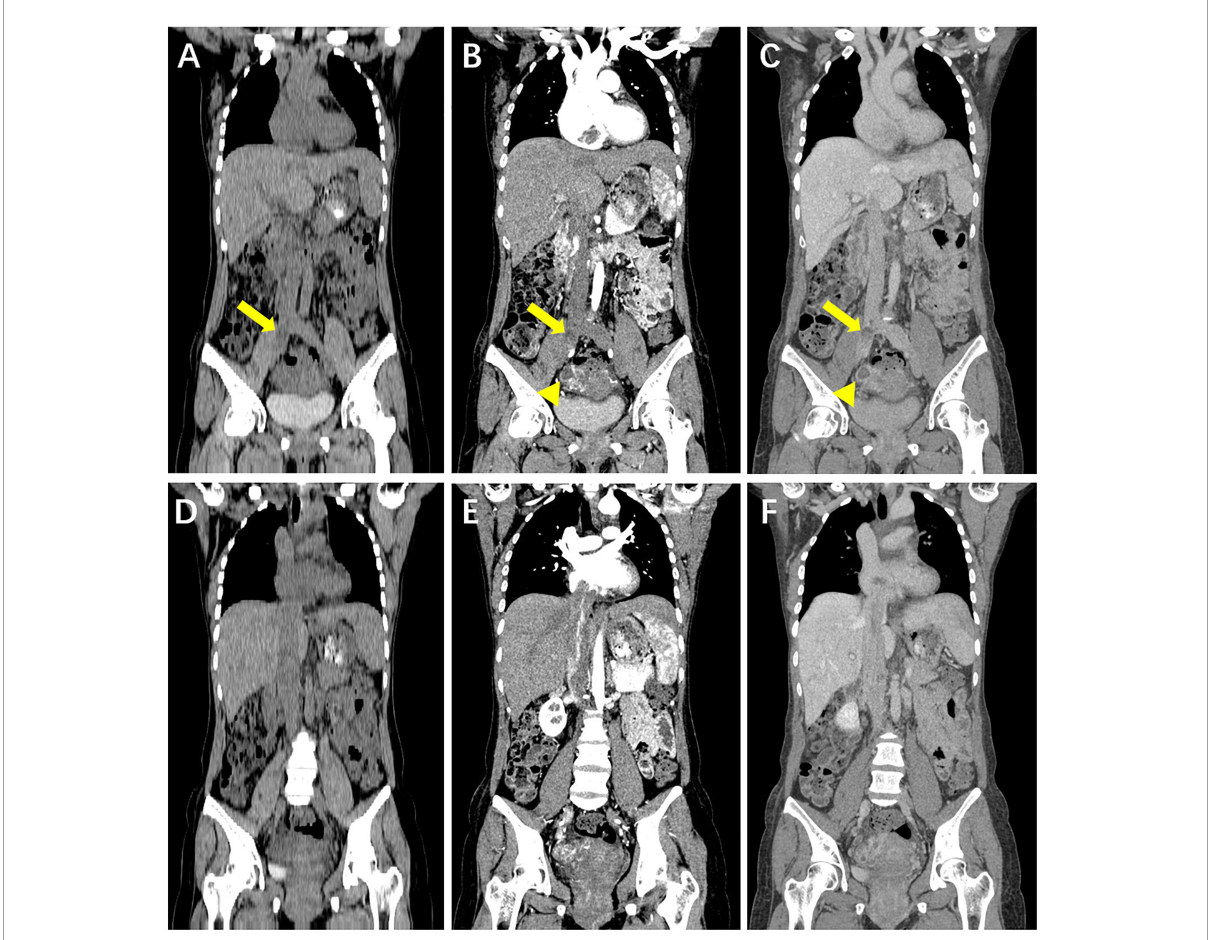
FIGURE1 Coronal reformatted computed tomography (CT) image of the chest, abdomen and pelvis. (A–F) Hypoattenuating filling defect located within the right iliac veins across the inferior vena cava (IVC) into the right atrium. Contrast-enhanced CT images show that intravenous lesions demonstrated mainly moderate progressive enhancement, with localized non-enhancing necrotic areas (arrow). A circular enhanced thick-walled cystic lesion at the right of the uterine body is incidentally noted (arrowhead). (A,D) Unenhanced phase image. (B,E) Arterial phase of contrast enhancement image. (C,F) Portal phase of contrast enhancement